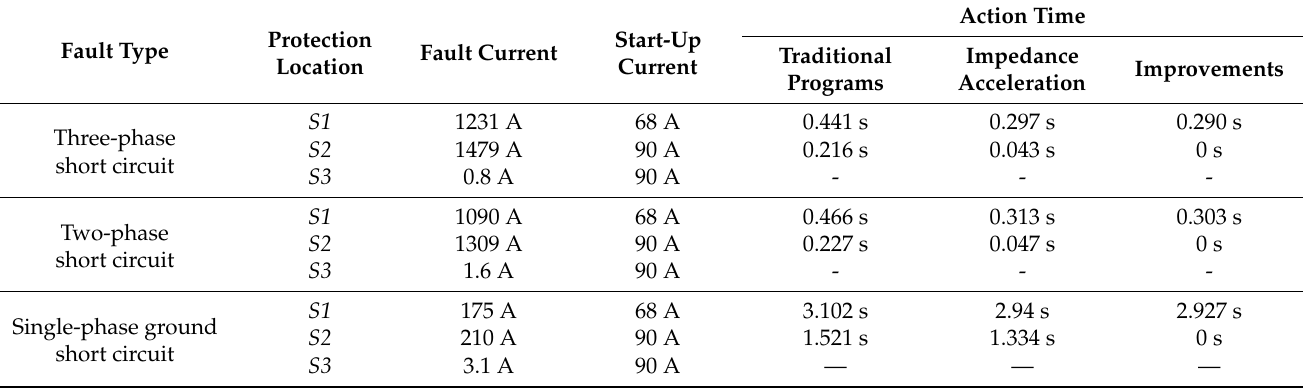
Table 6. Operating time of different protection schemes in the case of line BC via 0 Ω ground resistance